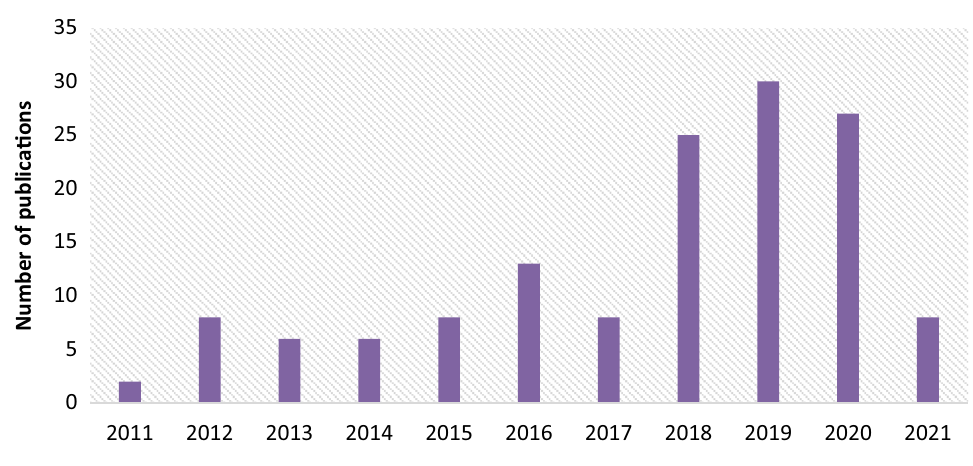
Figure 8. Annual distribution of